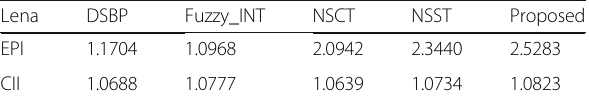
Table 3 Objective evaluation parameters for car image set